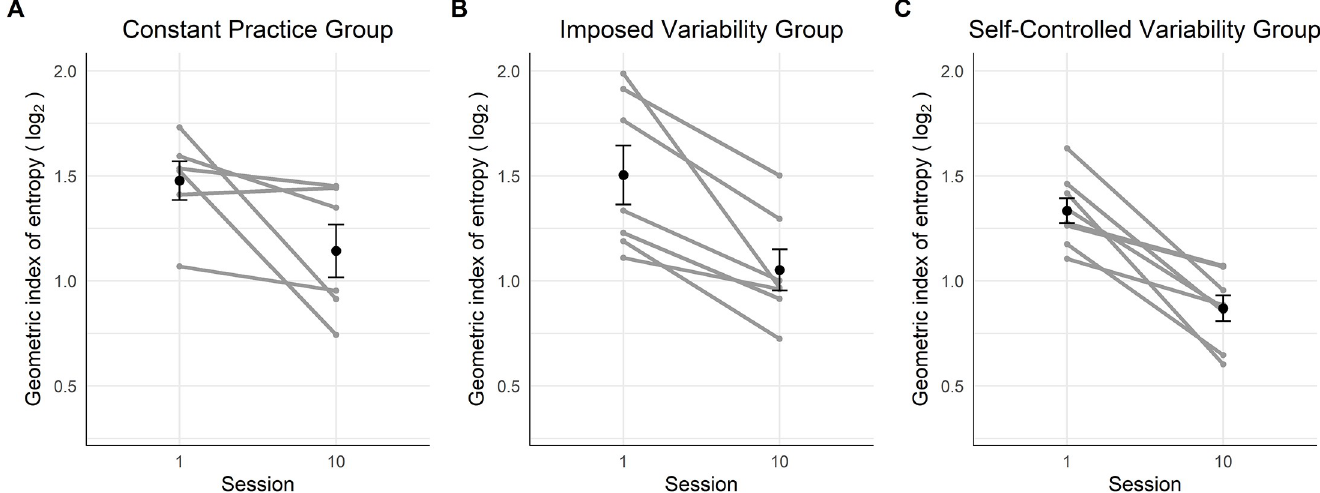
Fig 6. Changes in the climbing fluency of the three groups on the transfer route. The black points represent the sessions mean and the error bars their standard error. The grey points and lines represent each participant’s dynamics.